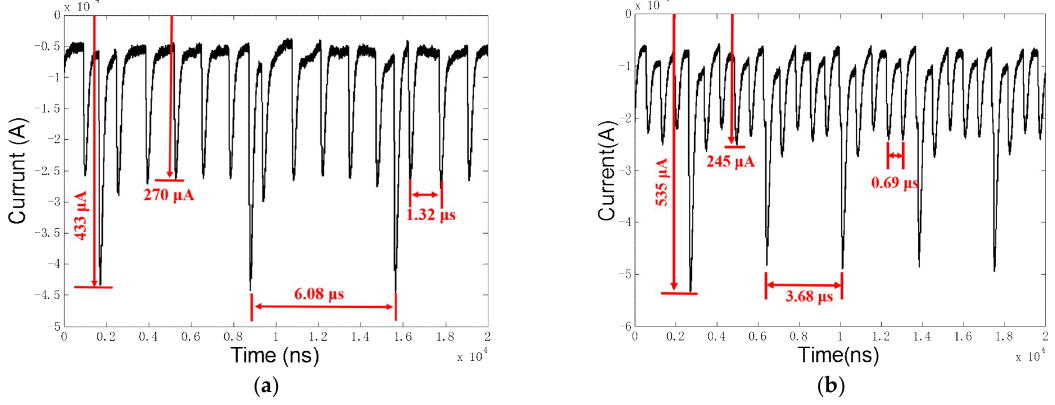
Figure 6. Negative corona discharge current waveform under double-needle discharge structure: ( a ) Applied voltage of 7.4 kV; ( b ) Applied voltage of 8.7 kV.